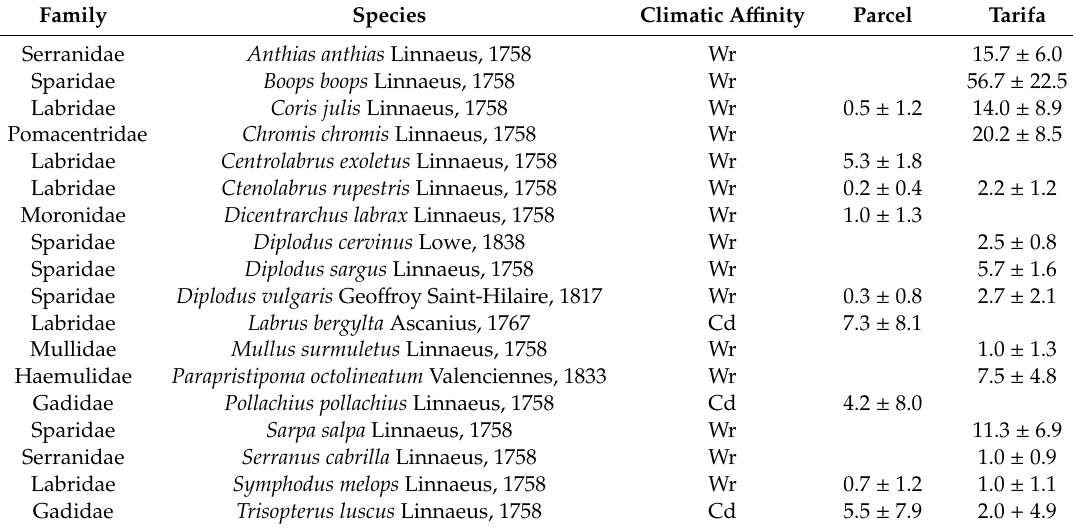
Table 1. List of fish species and abundance (individuals per 100 m 2 , mean ± SD, n = 6) identified in Parcel and Tarifa locations, along with their climatic a ffi nity: cold-water boreal (Cd) or warm-water Lusitanian (Wr) species. All taxonomic authorities were verified through cited references in [15]